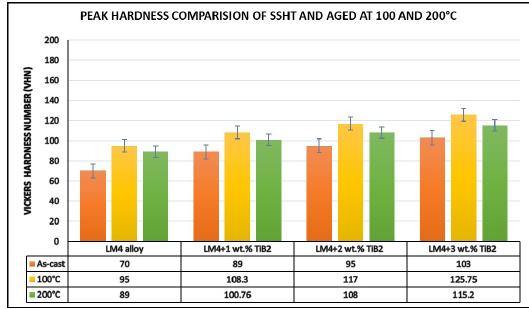
Figure 6. Peak hardness values of LM4 alloy and LM4 + TiB composites in as-cast and different aging conditions during SSHT.